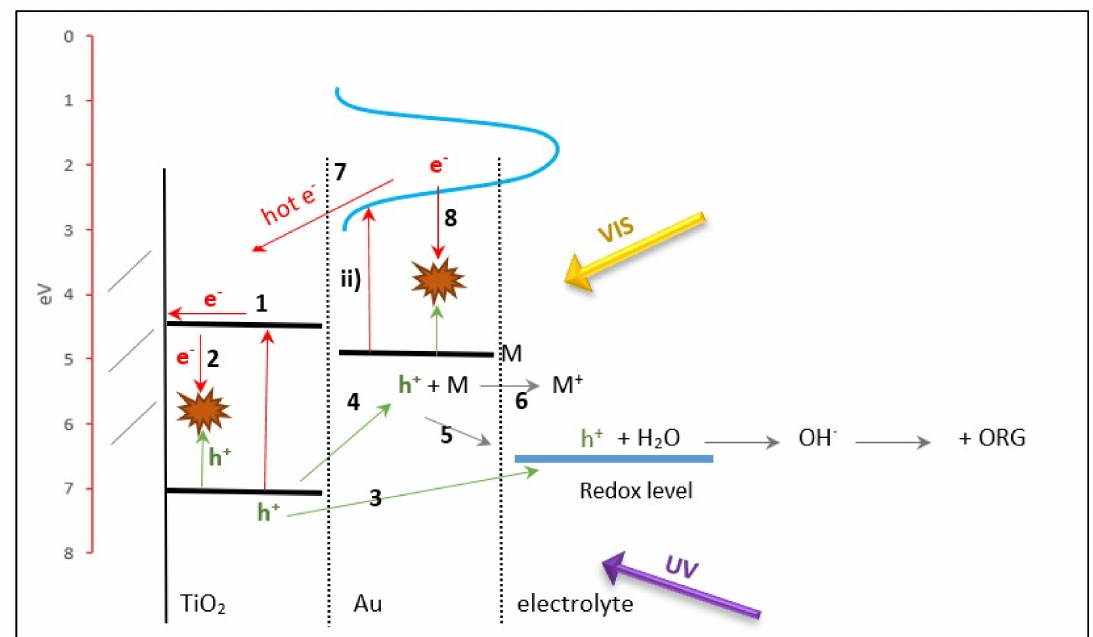
Figure 11. Schematic representation of the energetic levels involved in the charge activation and transfer